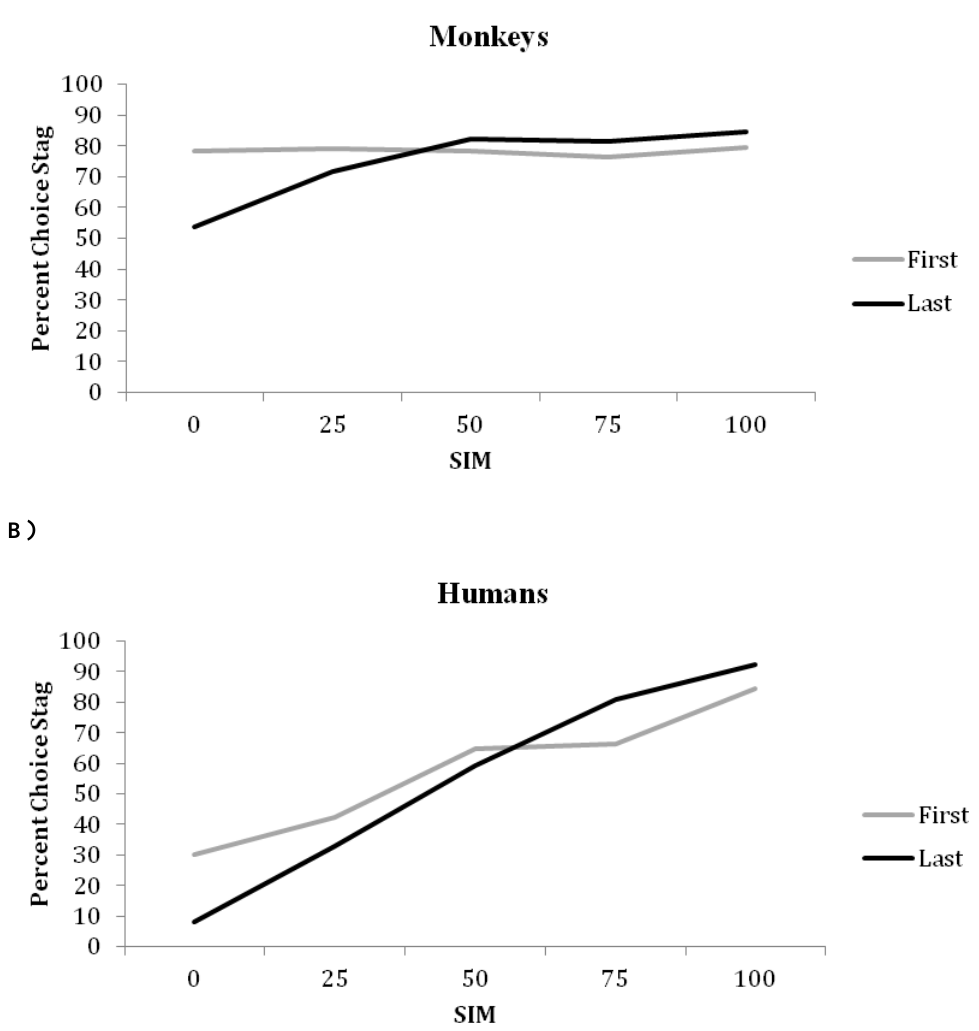
Figure 3. A) Mean percentage of trials on which the monkeys selected the Stag response in the first 20 trials (gray line) versus the last 20 trials (black line) within a 60-trial block. B) Mean percentage of trials on which the humans selected the Stag response in the first 15 trials (gray line) versus the last 15 trials (black line) within a 40-trial